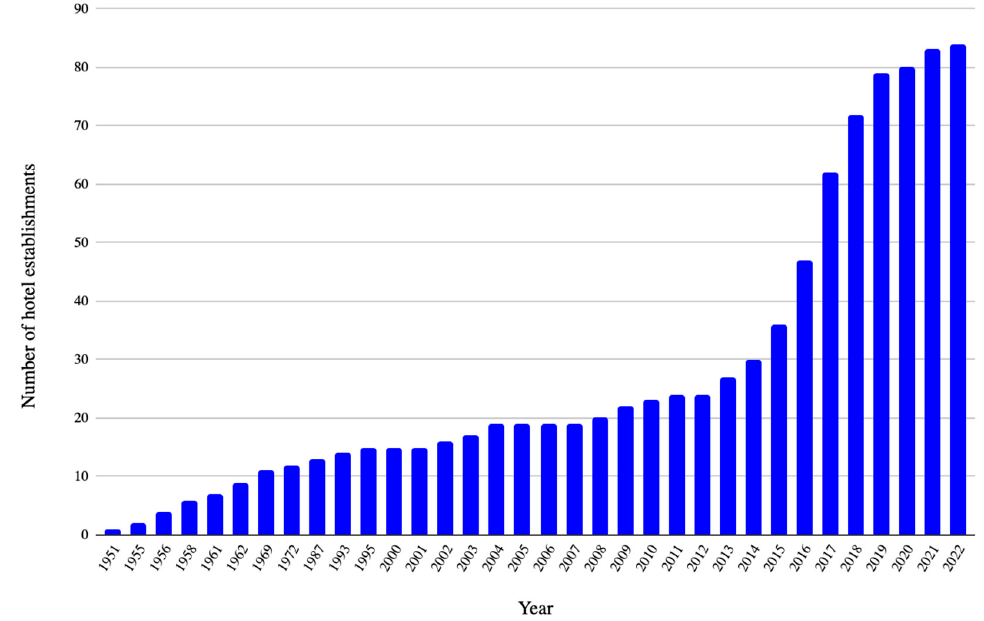
Figure 2. Evolution of the number of hotel establishments in the historic centre of Palma (1951–2022). Source: Authors and Register of Tourism Establishments of the Consell Insular de Mallorca.